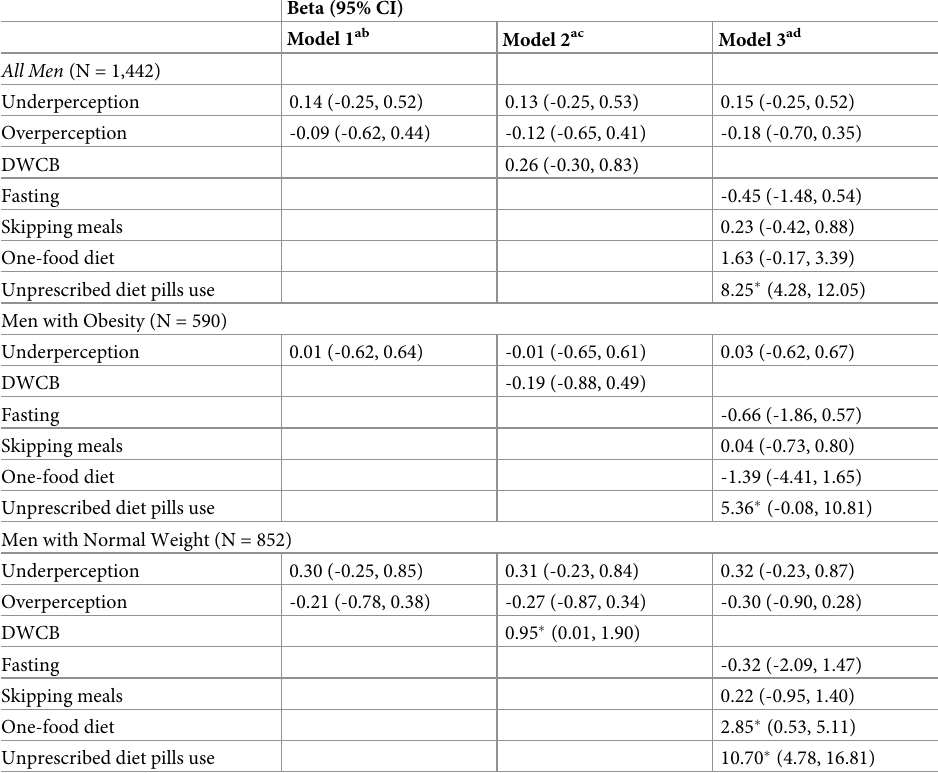
Table 3. Association of weight status perception pattern and disordered weight control behaviors with depressive symptoms (PHQ-9K) among Korean men (N = 1,442) aged 19–65 years with BMI > = 18.5kg/m 2 and no history of